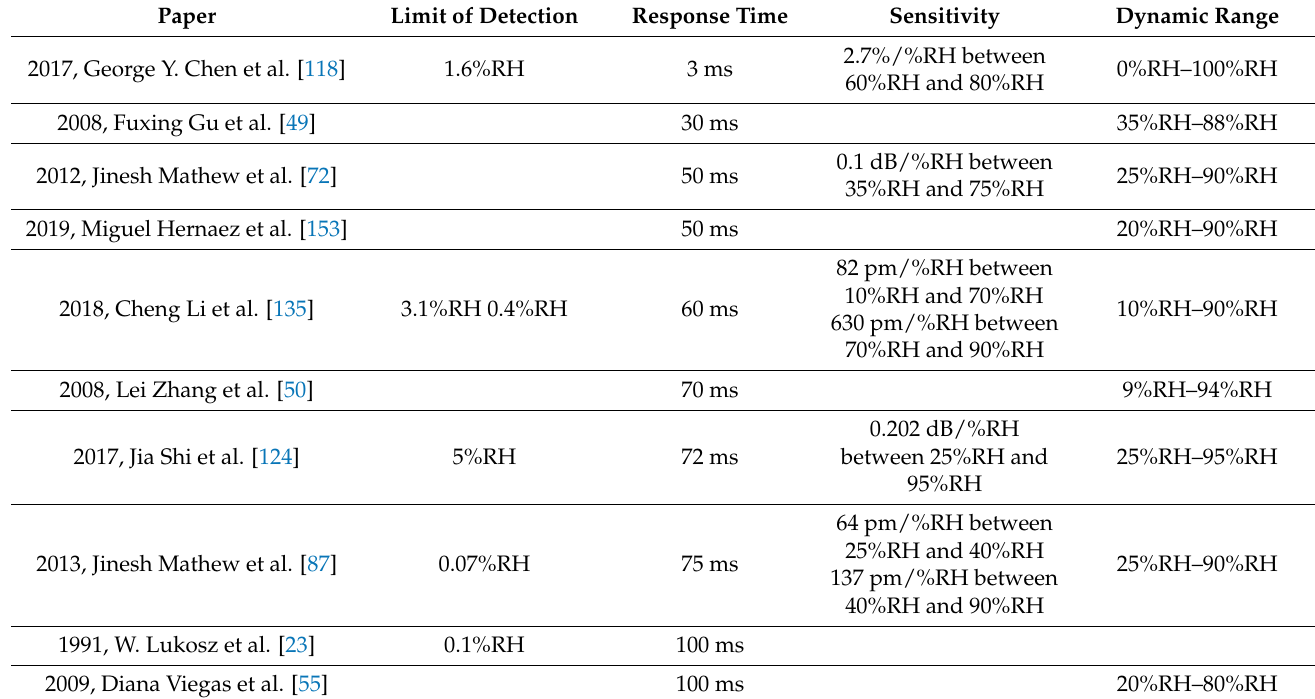
Table 2. Ranking of response time.